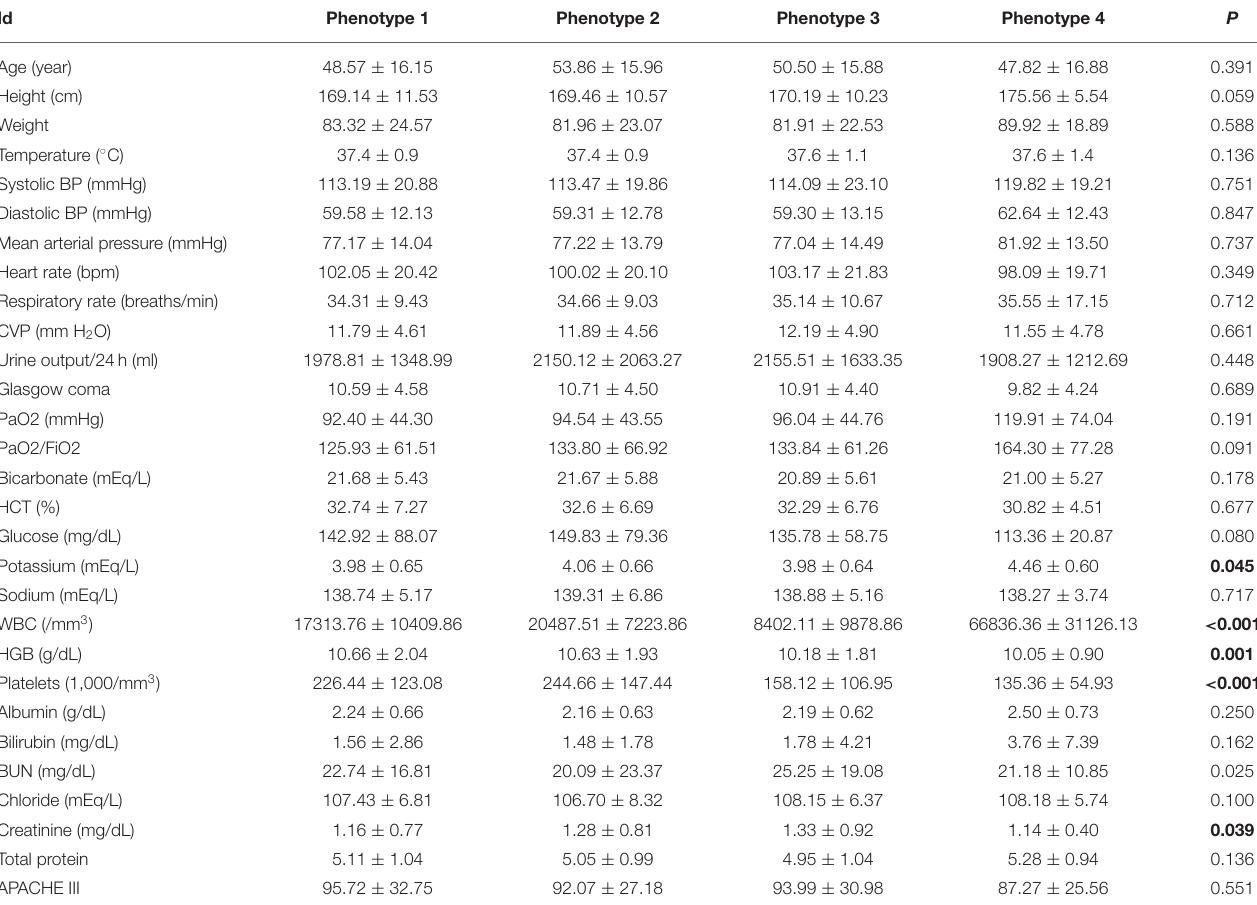
TABLE 3 | Continuous variables in different